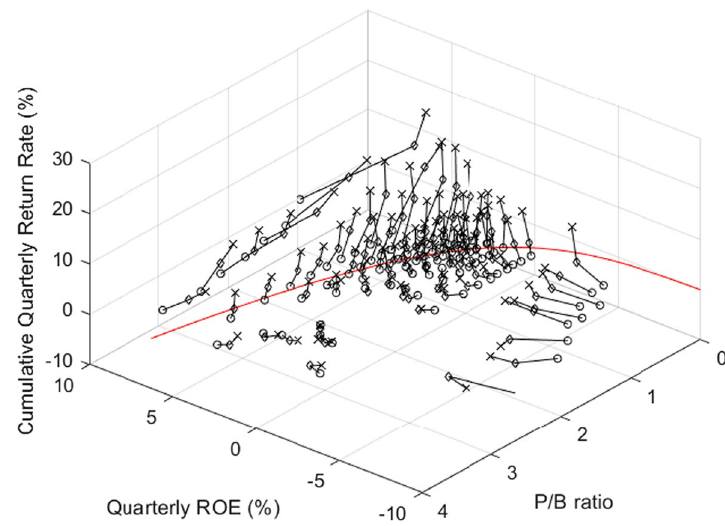
Fig. 22 The relationships among ROE, P/B, and cumulative quarterly return rates (circle, diamond, x‑mark: the data in the t, t 1, and t 2 quarter) + +